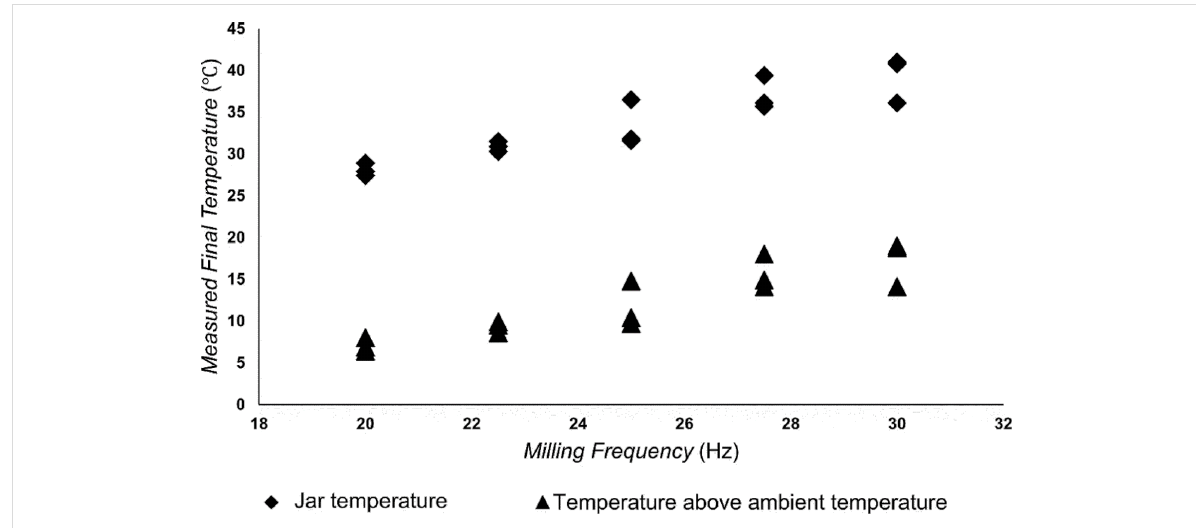
Figure 6: The effect of milling frequency on the internal jar temperature measured immediately after reaction completion.